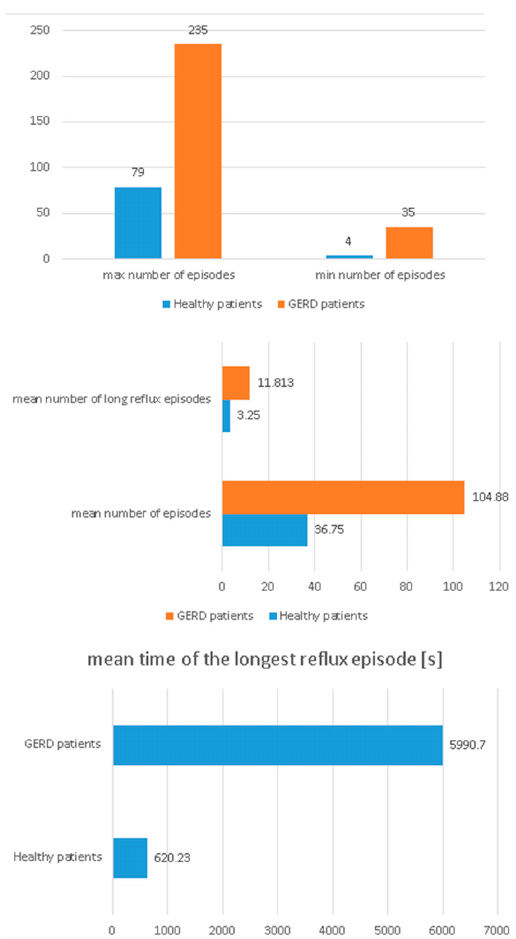
Figure 1. Selected statistical parameters of healthy patients and patients with GERD. Table 3. Statistical analysis of total DeMeester count parameters for healthy and GERD